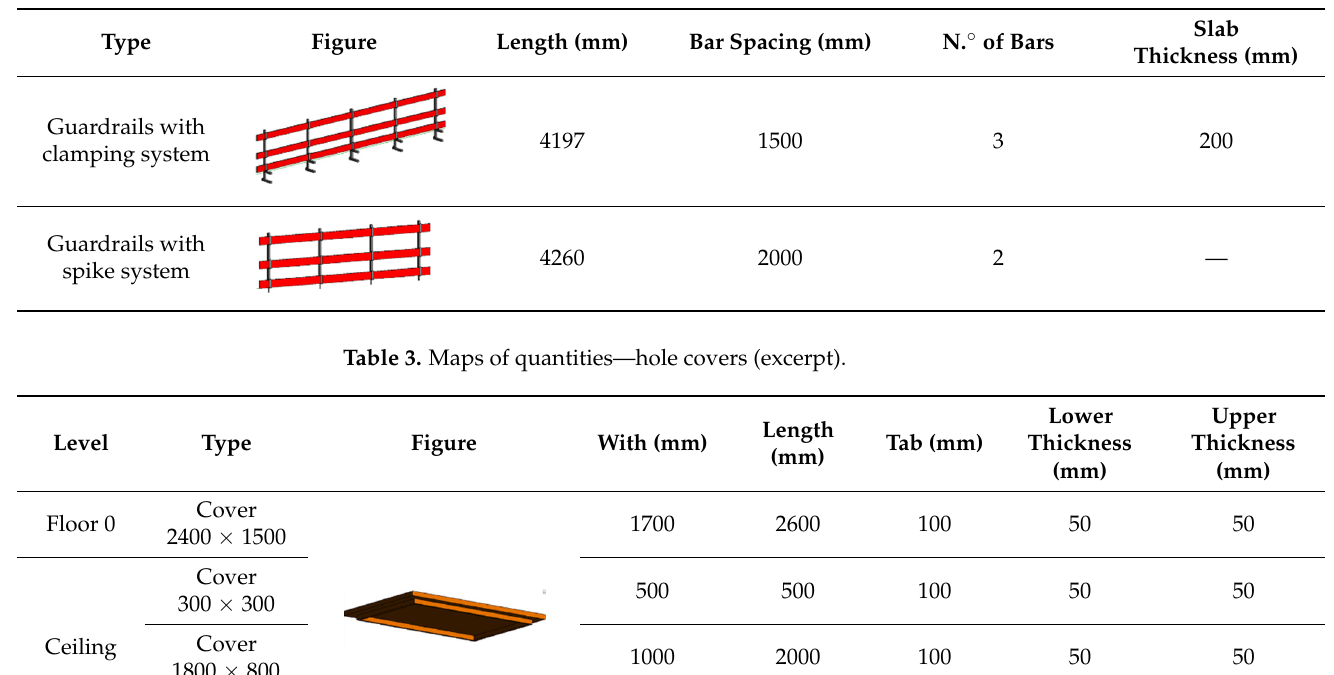
Table 2. Maps of quantities—guardrails hole covers (excerpt).